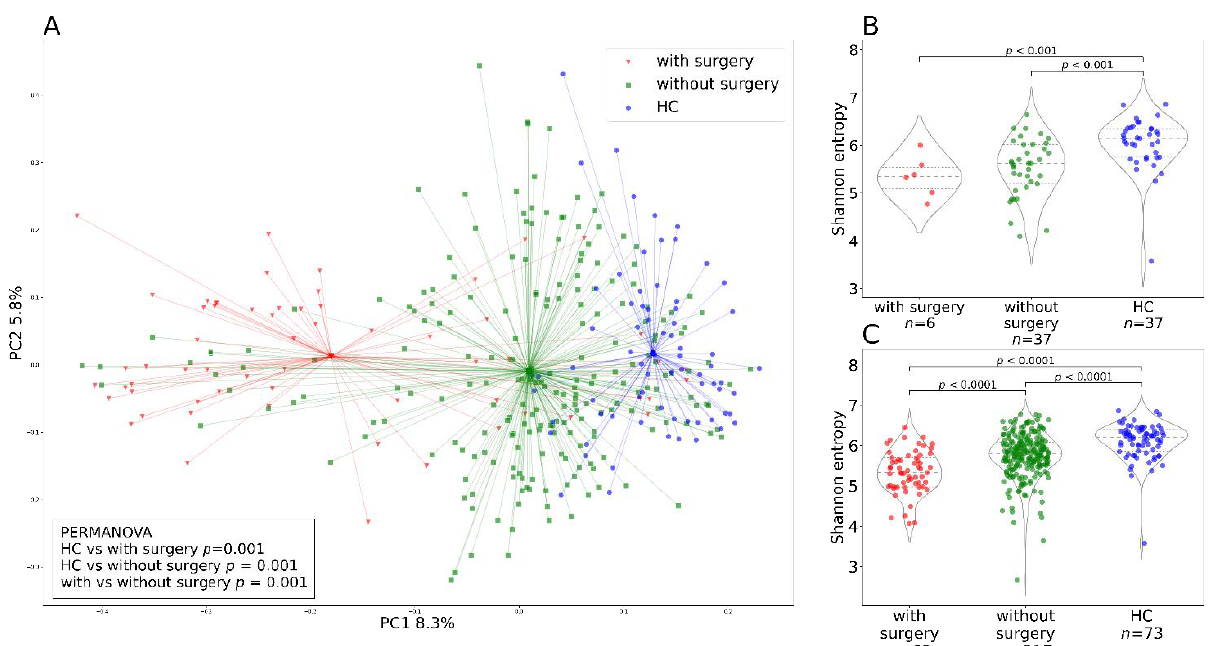
Figure 5. Alpha and beta diversity differences due to surgical procedure. ( A ) The PCoA plot shows beta diversity represented by the Bray–Curtis metric for patients with IBD with and without surgery, and healthy controls at various time points during the treatment including the baseline. Each dot represents a sample at a single time point and a line connects it to the cluster centroid. ( B ) Alpha diversity represented by Shannon entropy in Crohn’s disease patients at baseline categorized by intestinal surgery and in healthy controls. ( C ) Alpha diversity represented by Shannon entropy in the whole patients with IBD at various time points including baseline categorized by intestinal surgery and in healthy controls. Abbreviations: HC, healthy controls.